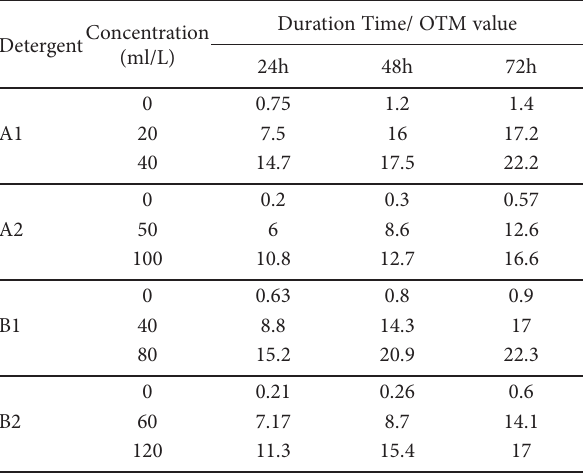
Table 6. The effect of the detergents on OTM values in V. faba. DetergentConcentration